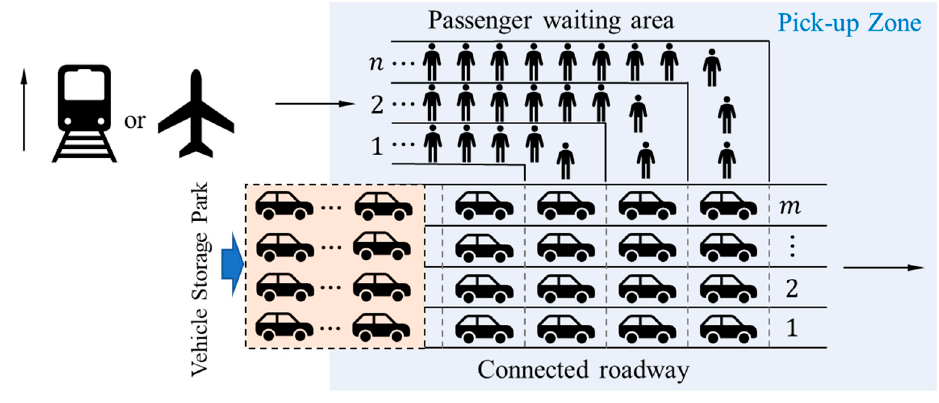
Figure 1. An illustration of the study system.